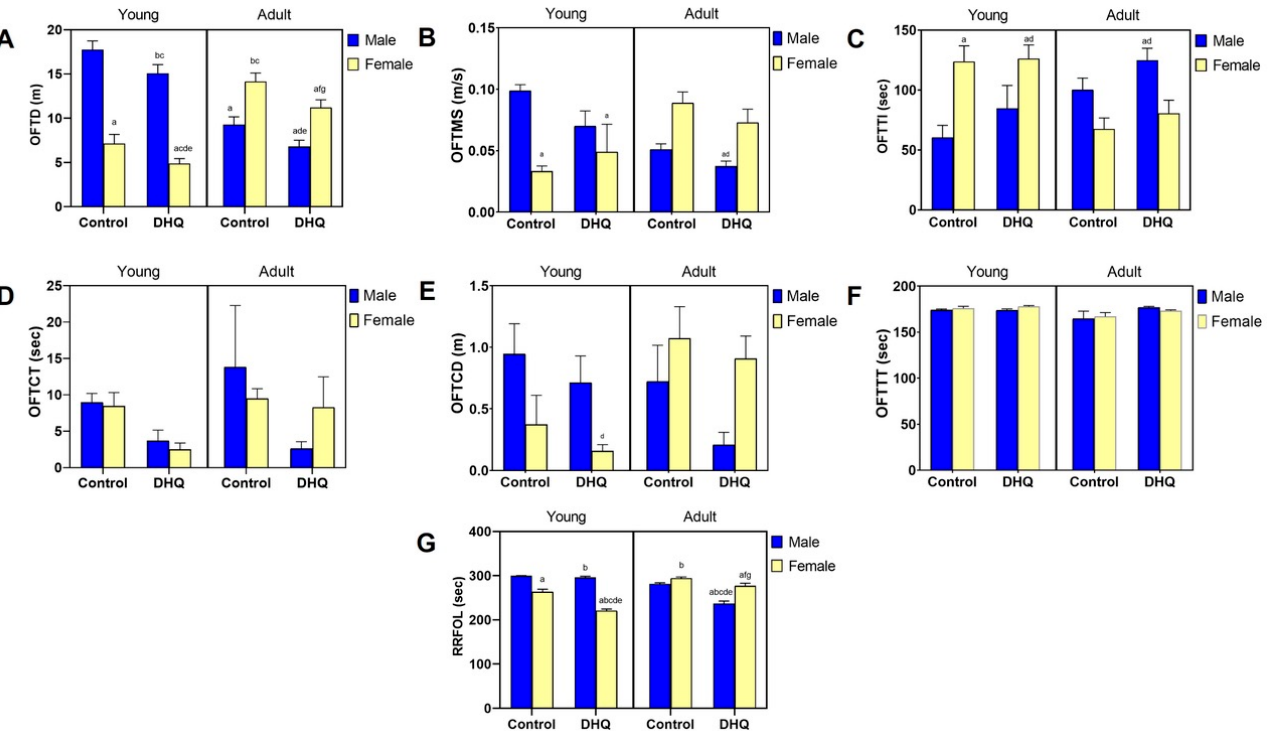
Figure 1. Motor impairments instigated by diiodohydroxyquinoline administration in young/adult male/female rats. Panels represent: ( A ) distance traveled (OFTD), ( B ) mean speed (OFTMS), ( C ) time immobile (OFTTI), ( D ) central time (OFTCT), ( E ) central distance (OFTCT), and ( F ) thigmotaxis time (OFTTT) in the open field test as well as ( G ) fall off latency (RRFOL) in the rotarod test. Each bar with a vertical line represents the mean ± S.D. of 10 rats per group. a vs. control young male, b vs. control young female, c vs. control adult male, d vs. control adult female, e vs. DHQ young male, f vs. DHQ young female, and g vs. DHQ adult male using three-way ANOVA followed by Tukey’s post hoc test; p < 0.05. DHQ; diiodohydroxyquinoline.